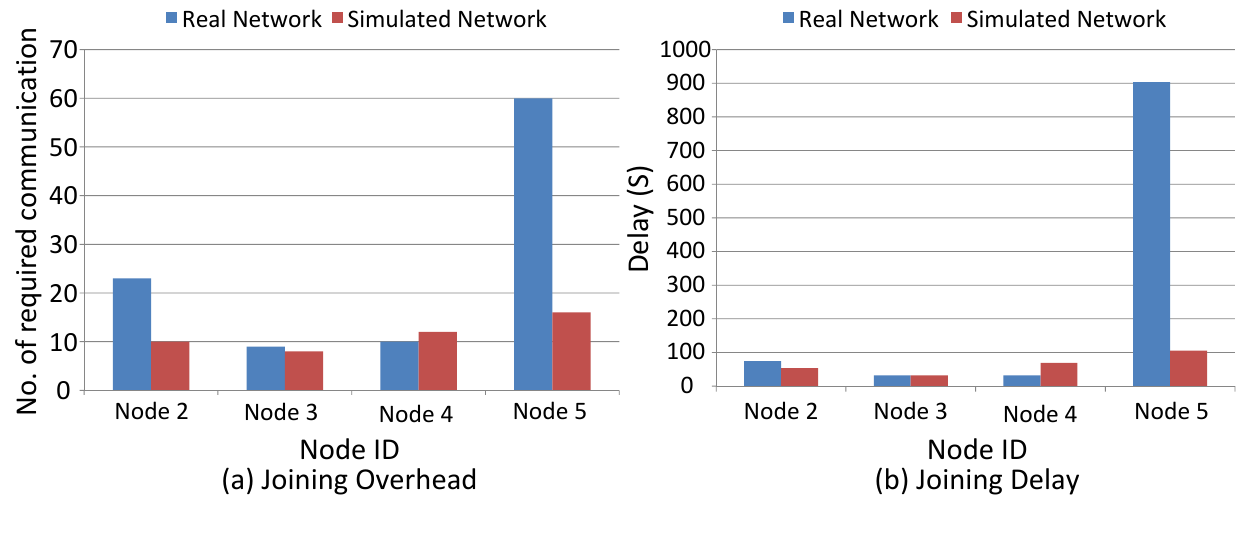
Field device joining overhead ( a ) and delay ( b ) (real vs . simulated WirelessHART network).